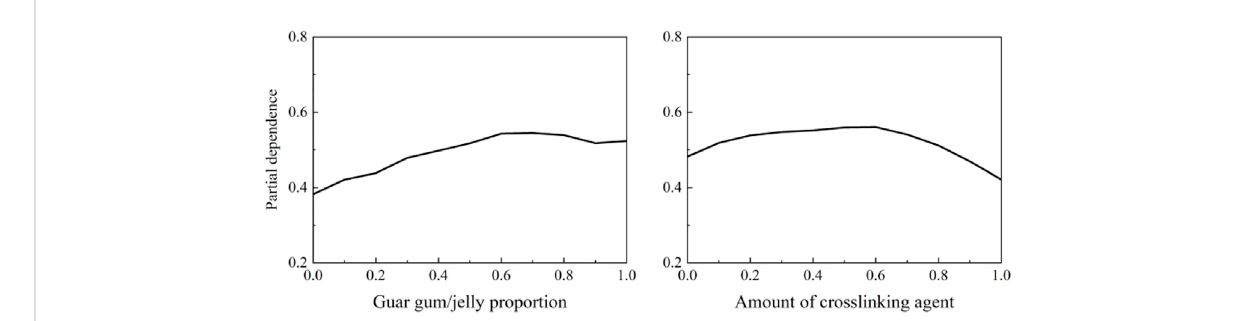
FIGURE 7 Partial dependency plot of engineering parameters(A) of GEP model.